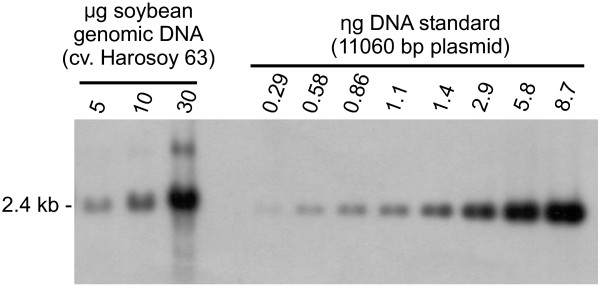
Hps gene copy number determination by reconstruction hybridization. Soybean (Glycine max cv. Harosoy 63) genomic DNA, or an 11060 bp plasmid carrying a soybean chromosome fragment encoding a single copy of Hps (GenBank accession DQ208939) were digested with Bgl II and separated by agarose gel electrophoresis. The DNA was transferred to Nylon blotting membrane and probed with 32P labelled Hps cDNA (GenBank accession number AF100159). Shown above each lane is the amount of DNA loaded for the soybean genomic DNA (μg) or for the plasmid standard (ng). The size of the main hybridizing fragment is indicated on the left. Analysis of the band intensities using a phosphoimager results in a calculated value of 27 ± 5 copies of Hps per haploid genome, for the 2.4 kb Bgl II fragment.